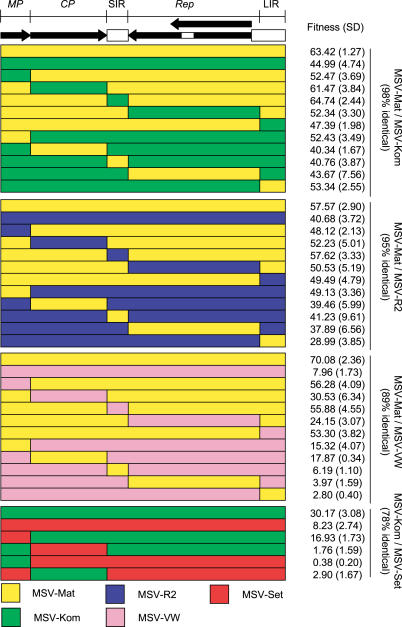
Laboratory Constructed MSV Recombinants and Their Relative Fitness (as Measured by ICLAs) in MaizeFive genome regions corresponding to the three MSV genes (MP, CP, and Rep) and two intergenic regions (LIR and SIR) were reciprocally exchanged between four pairs of MSV isolates (MSV-Mat/MSV-Kom, MSV-Mat/MSV-R2, MSV-Mat/MSV-VW, and MSV-Kom/MSV-Set). Genome-wide sequence identities are indicated. SD, standard deviation.